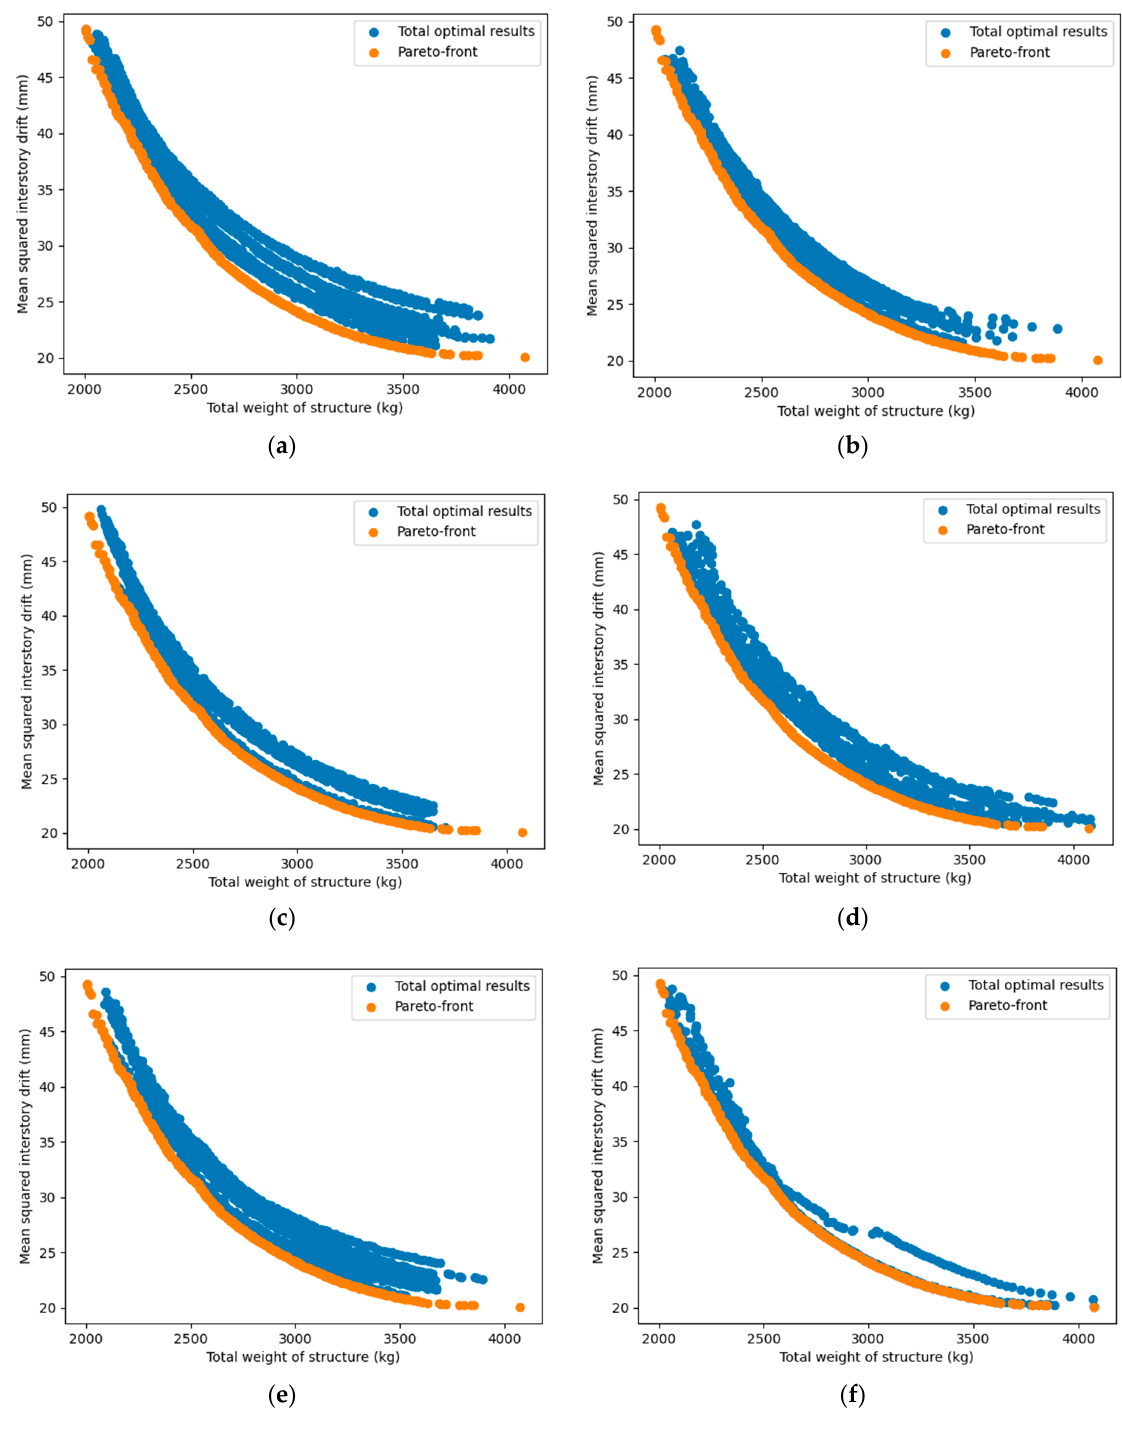
Figure 7. Paretal-front compared to the optimal solutions of the MOO algorithms in the 10-bar truss: ( a ) NSGA-II; ( b ) NSGA-III; ( c ) GDE3; ( d ) OMOPSO; ( e ) SPEA2; ( f ) MOEA/D.